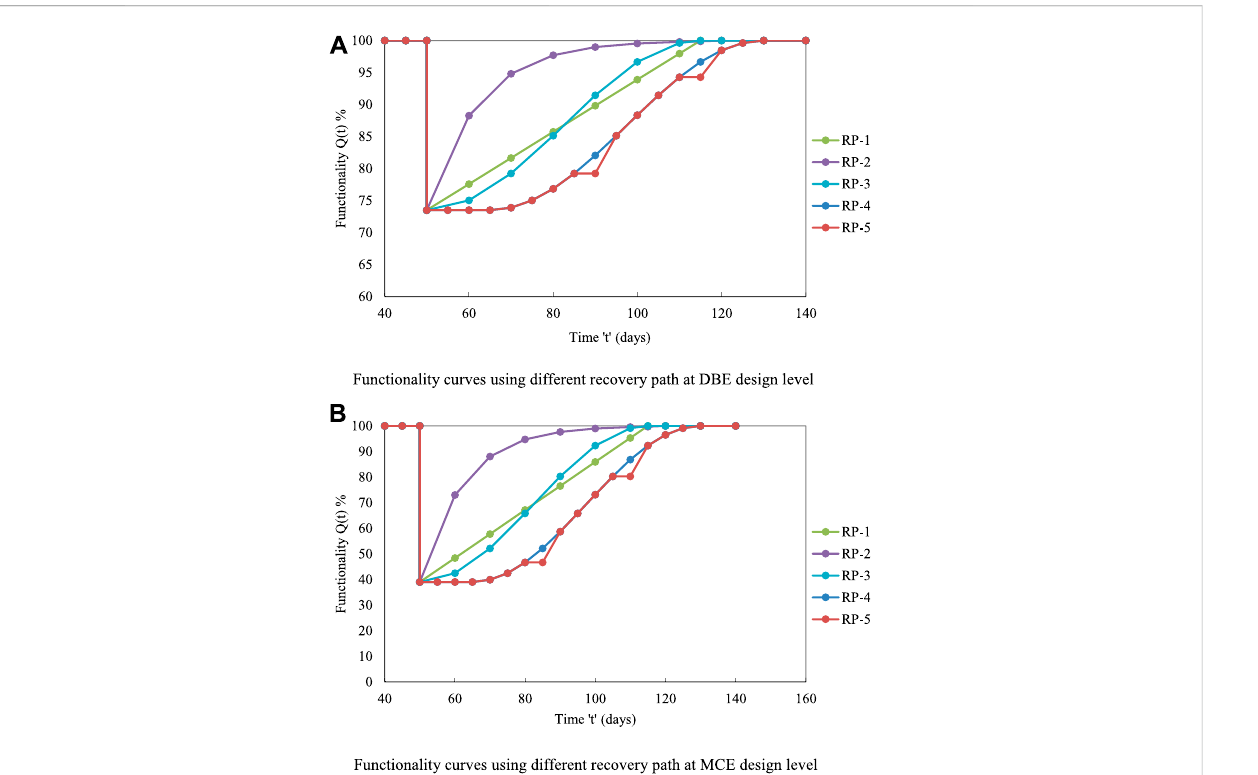
FIGURE 7 Functionality curves for case I building with respect to various recovery paths. (A) Functionality curves using different recovery paths at DBE design level. (B) Functionality curves using different recovery paths at MCE design level.